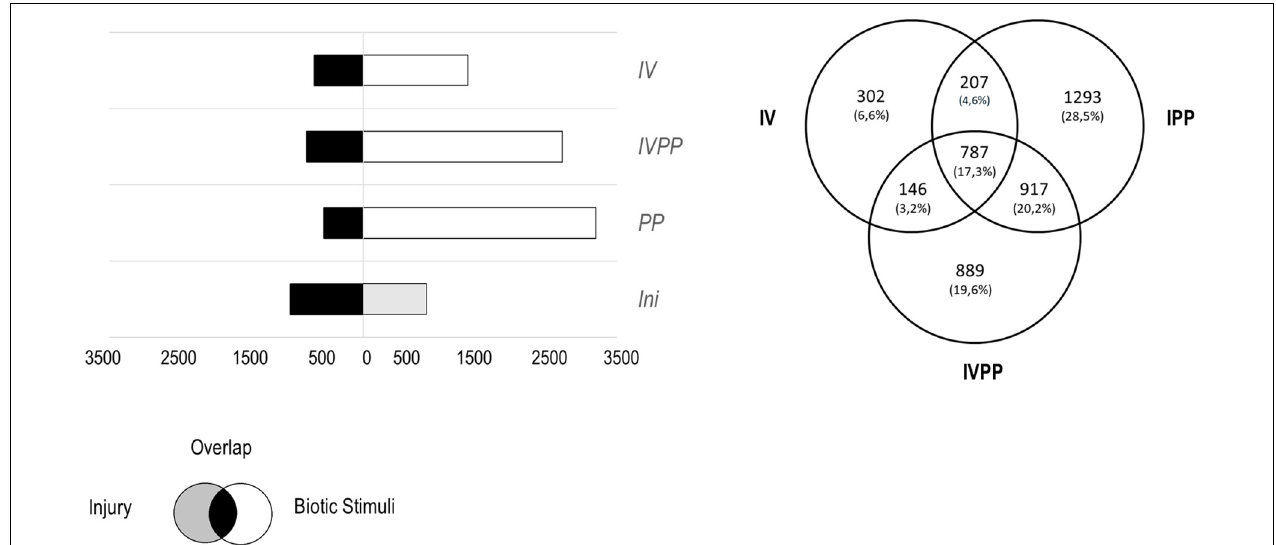
FIGURE 1 | (A) Number of the total differentially expressed genes (DEGs, p-value < 0.05) by the injury, in the presence of Vintec R (cid:13) (IV), during the infection (IPP) or during the infection in plants pre-inoculated with Vintec R (cid:13) (IVPP). In black, DEGs induced by the injury and the biotic stimulus; in gray, DEGs induced by the injury alone; in white, DEGs induced by each of the three biological stimuli. (B) Venn diagram representing specific and common DEGs for all the three biotic stimuli.